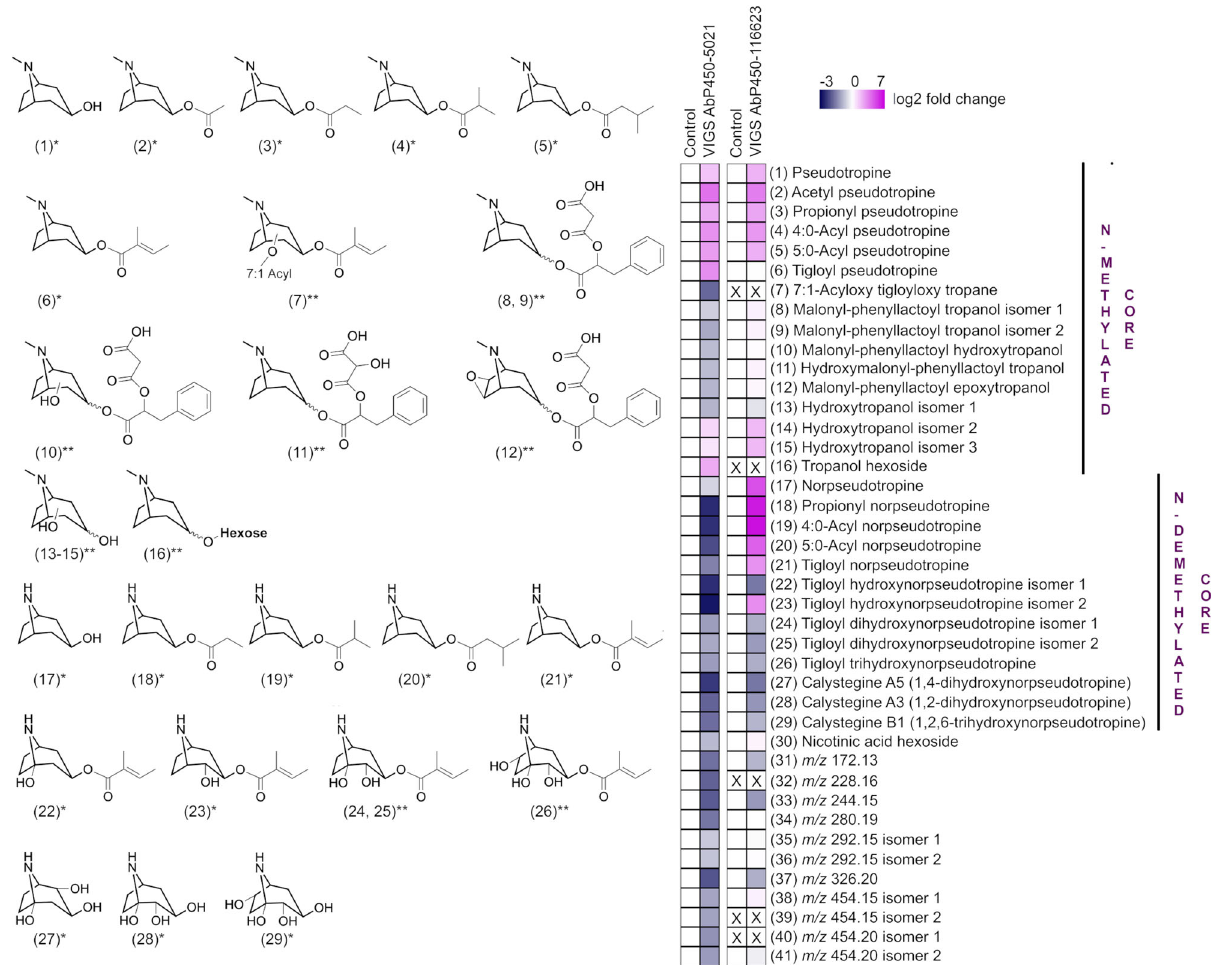
Fig. 2 Metabolic changes in roots of AbP450-5021 VIGS and AbP450-116623 VIGS lines relative to control lines. Structures of annotated alkaloids with pseudotropine and norpseudotropine cores are shown (*, authentic reference; **, putative structure based on UHPLC/MS/MS data, reported in Supplementary Data 1). Heat maps depict log2-fold changes in the metabolite levels in VIGS lines relative to control lines (white, control level; gray-blue, decreased level; purple: increased level; X: below limit of detection S/N < 3). Source data are provided as a Source Data fi